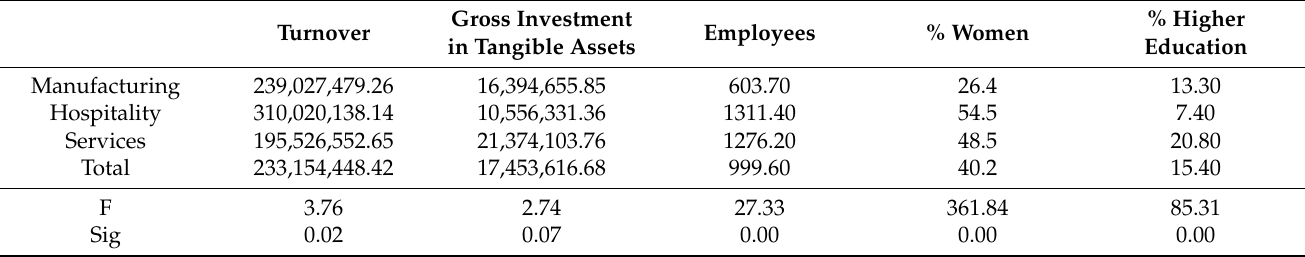
Table 3. Profile of